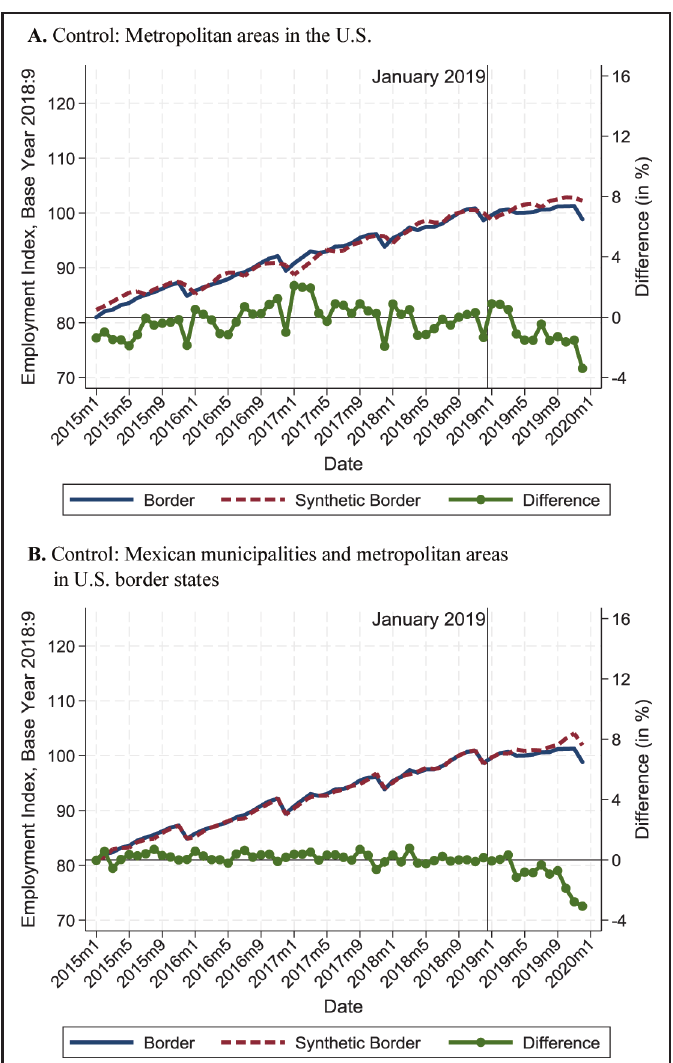
Robustness test using metropolitan areas in the United States as controls,